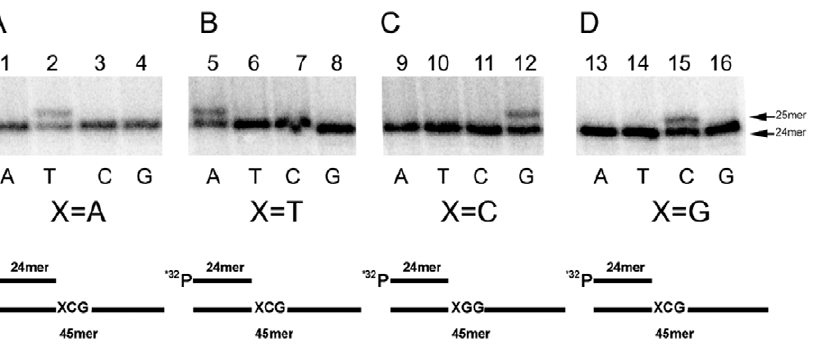
Figure 4. Nucleotide insertion fidelity of EhDNApolA. 16% denaturing polyacriylamide gel showing a primer-template extension by EhDNApolA in the presence of 100 m M of the indicated nucleotide. The first templated base is denoted with an X as depicted in figures A, B, C, and D. The identity of each dNTP in each reaction is indicated. The 24mer substrates and the 25mer products are indicated by an arrow. ( A ) Nucleotide fidelity for templated adenine (lanes 1 to 4). ( B ) Nucleotide fidelity for templated thymine (lanes 5 to 8). ( C ) Nucleotide fidelity for templated cytidine (lanes 9 to 12). ( D ) Nucleotide fidelity for templated guanine (lanes 13 to 16).